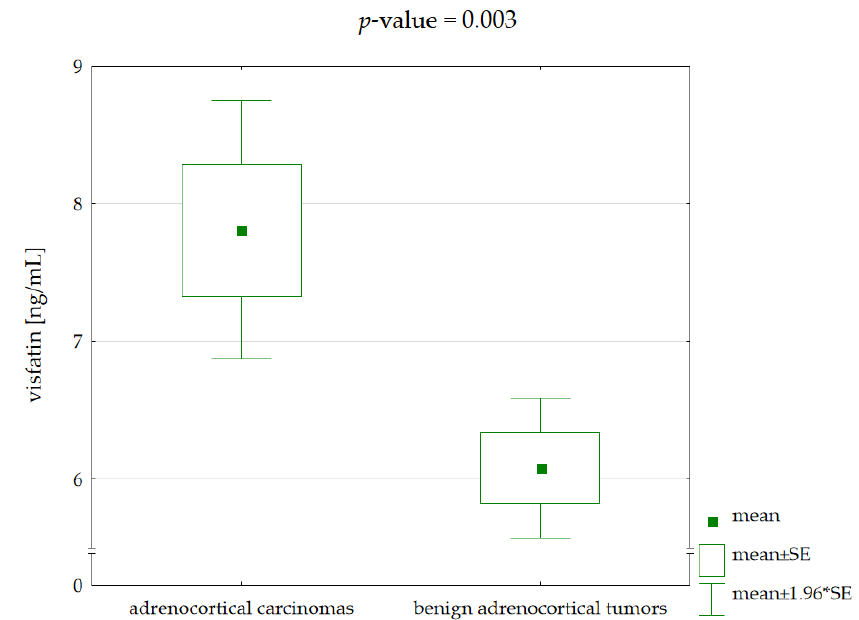
Figure 1. Comparison of visfatin serum concentrations between patients with adrenocortical carcinomas and benign adrenocortical tumors ( p -value for Welch’s t -test). Table 3. Correlation coefficients (R) for visfatin serum level and clinicopathological parameters.